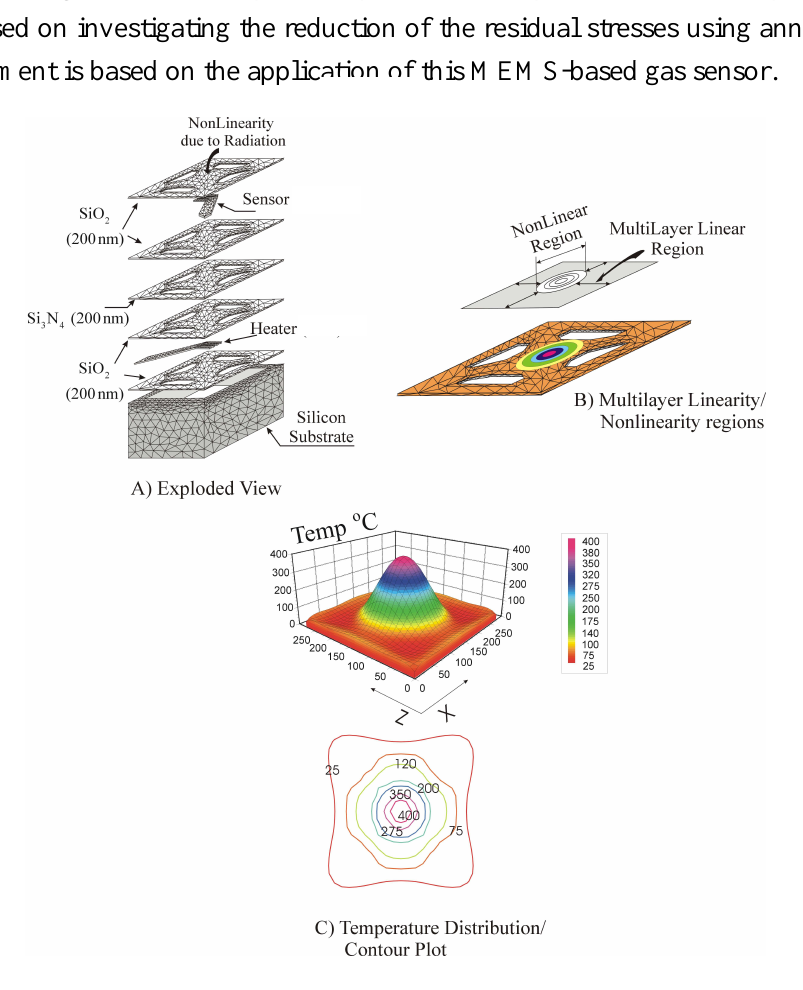
Figure 2 . MEMS gas sensor FE